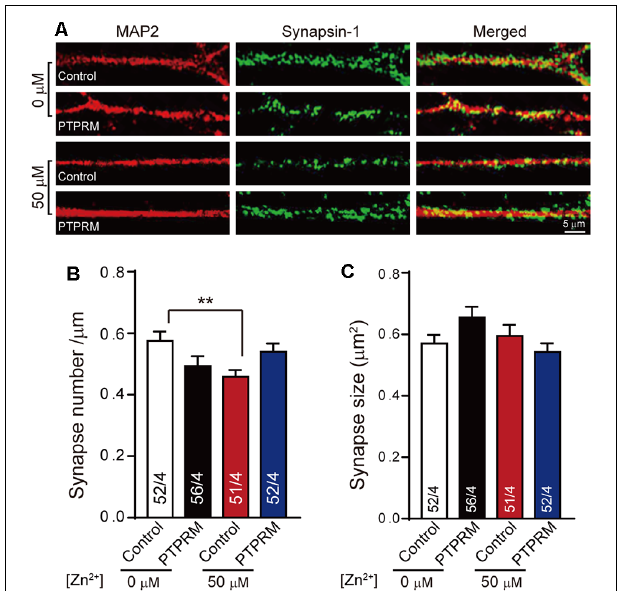
FIGURE 4 | PTPRM is critical for synapse formation regulated by Zn 2+ . (A) Representative images of neurons overexpressed PTPRM or not cultured with/without 50 µ M Zn 2+ when expressed PTPRM or not. Neurons were fixed and labeled by synapsin1 (to mark synapses) and Map AP2 (to mark dendrites) antibodies. The scale bar in the right lower corner applies to all images. (B) Summary graphs of synapse number calculated from the number of synapsin1-specific puncta for the conditions described in (A) . (C) Summary graphs of synapse size calculated from the area of synapsin1-specific puncta for the conditions described in (A) . Data information: numbers of cells/independent cultures analyzed are listed in the bars. Data shown in summary graphs are mean values ± SEM. Statistical significance was analyzed by Student’s t -test. ** p < 0.01. Scale bar: 5 µ m.